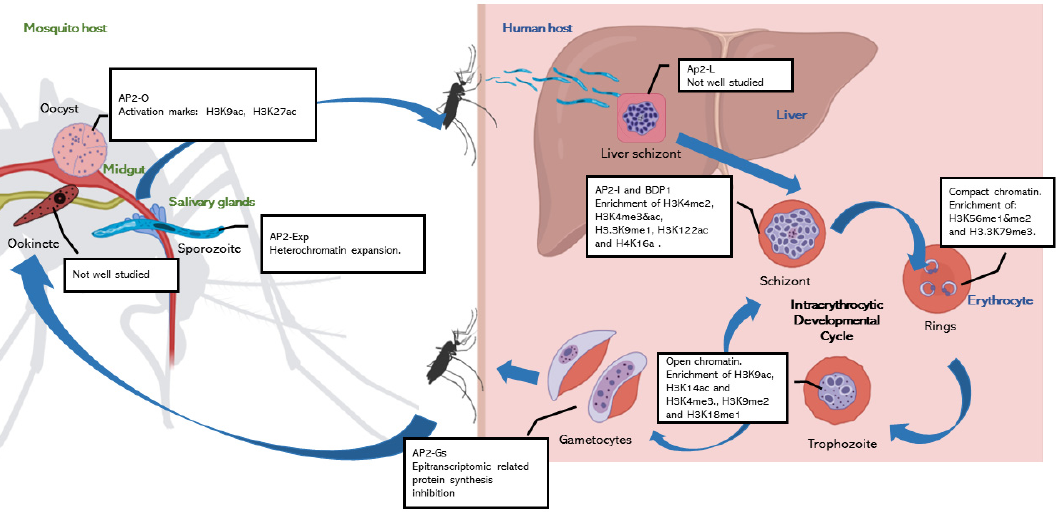
Figure 1. P. falciparum life cycle diagram with the more studied life stages at epigenetic level. The white boxes highlight the main epigenetic traits of the corresponding stage. Once the Anopheles mosquito bites a human host, sporozoites are released to the bloodstream and migrate to the liver. After hepatocyte invasion, P. falciparum invades the red blood cells and starts its Intraerythrocytic Developmental Cycle (IDC). Current evidence shows that in each stage of the blood cycle, chromatin structure is reshaped impacting transcription, and this is associated to differential accessibility, AP2 binding and histone modification patterns. In response to certain within-host factors, some parasite cells exit the IDC and differentiate into the transmissible stage of the gametocyte. The gametogenesis process is under the epigenetic control of the AP2-G regulatory cascade. Parasite transcriptional regulation during development in the mosquito (sporogonic cycle) is little studied, epigenetic data are only available for oocyst and sporozoite mosquito stages. Various AP2 TFs appear to act as master regulators of mosquito-specific parasite genes.